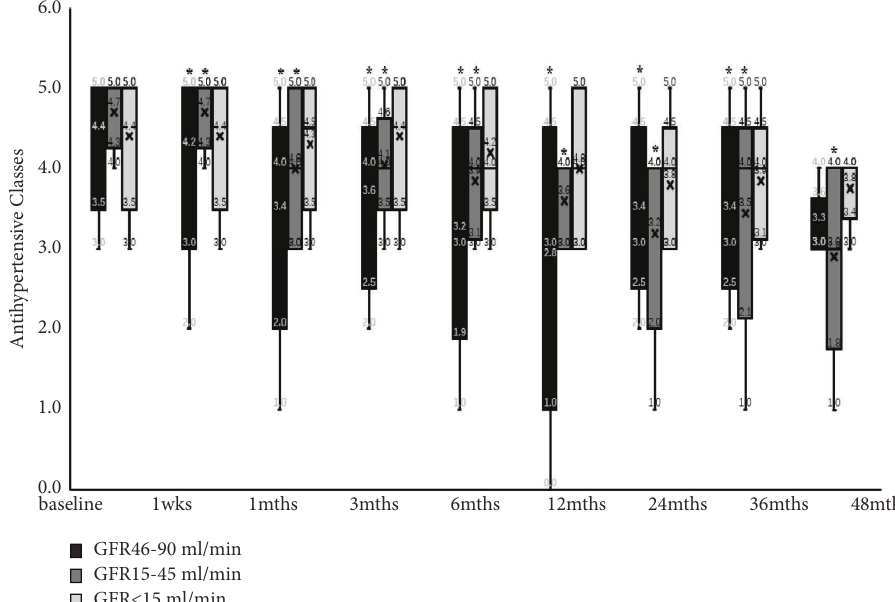
Figure 4: Changes of antihypertensive classes from baseline to 48 months. Note: SBP:systolic blood pressure; DBP :diastolic blood pressure; ∗ P < 0 . 05, compared with baseline.